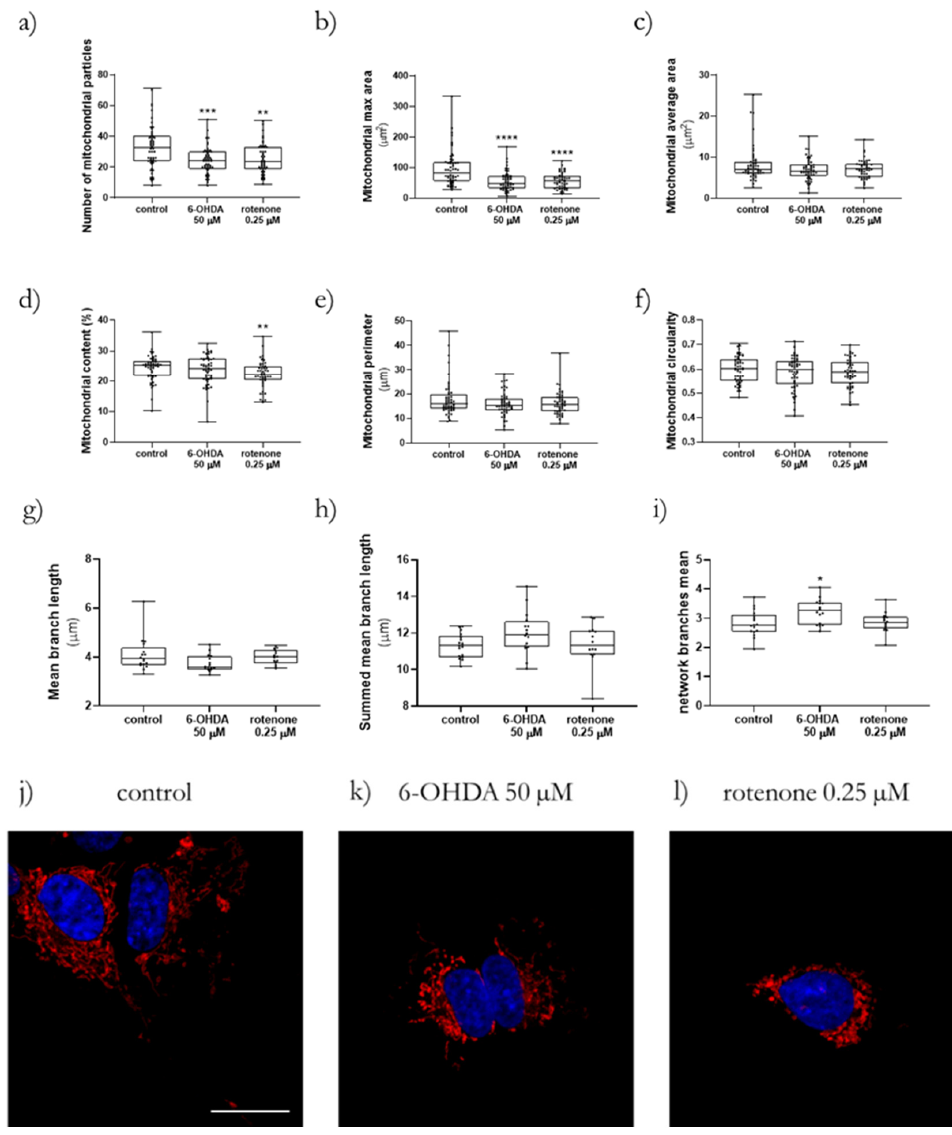
Figure 4. Non-toxic concentrations of 6-OHDA and rotenone promoted alterations in mitochondrial morphology. The mitochondrial morphology parameters number of mitochondrial particles ( a ), maximal mitochondrial area ( b ), mitochondrial average area ( c ), mitochondrial content ( d ), mito- chondrial perimeter ( e ), and mitochondrial circularity ( f ) were analyzed using the Mito-Morphology macro, while the mitochondrial mean branch length ( g ), summed mean branch length ( h ), and network branches mean ( i ) were evaluated using the MiNA toolset. Mito-Morphology data are represented in boxplots in which each dot represents an individual cell ( n = 49–55). MiNA toolset data are represented in boxplots in which each dot represents an independent cell population ( n = 14–17). Kruskal–Wallis test (one-way ANOVA on ranks) pairwise (control vs. 6-OHDA or control vs. rotenone) was used to assess statistical significance, (*) p < 0.05, (**) p < 0.01, (***) p < 0.001 and (****) p < 0.0001. Representative images were obtained by confocal microscopy (63 × objective), scale bar = 20 µ m. Nuclei staining is presented in blue and Mitotracker Red CMXRos is presented in red ( j – l ). Cells were treated 24 h with 50 µ M 6-OHDA ( k ) or with 0.25 µ M rotenone ( l ). Non-treated cells are presented in ( j